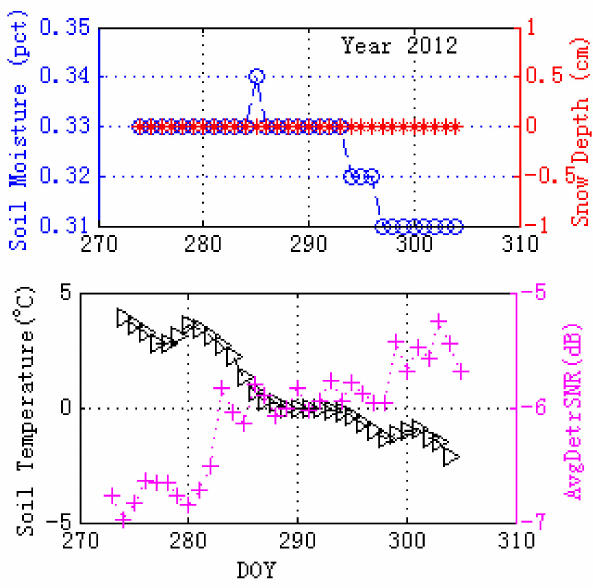
Figure 9. Comparisons between GPS site (AB33) and SNOTEL site (ID 958) from DOY 270 (2012) to DOY 305 (2012). The elevation angle is 20 ◦ . The upper panel presents the comparisons of soil moisture (blue O) and snow depths (red *). Comparisons of soil temperature (black (cid:52) ) and ADSNR (pink +) are presented in the bottom panel.